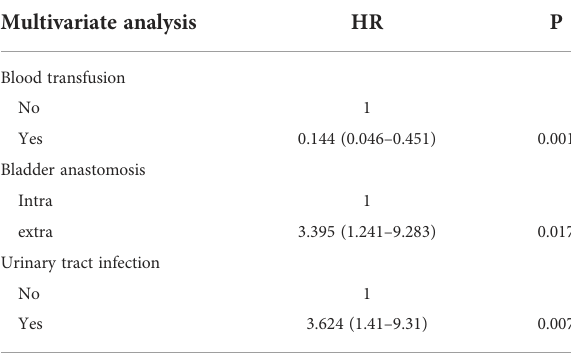
TABLE 3 Multivariable Logistic regression